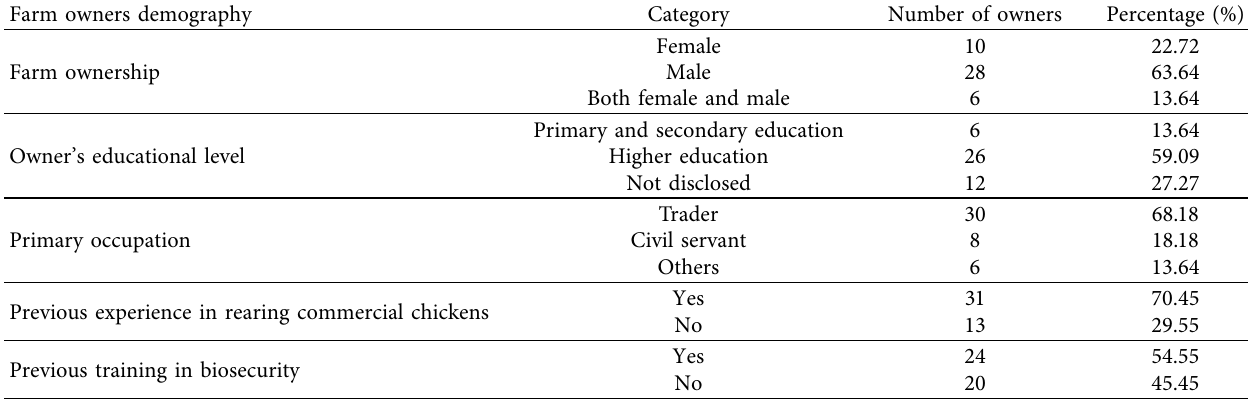
Table 1: The demography of chicken farm owners involved in biosecurity evaluation.